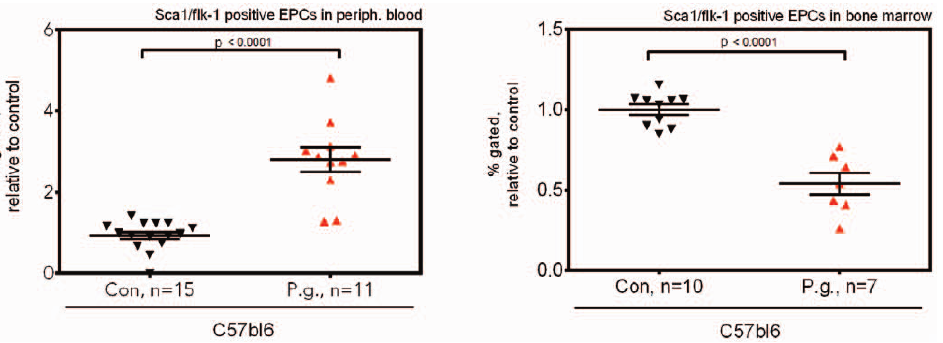
Figure 1. Bacteremia with P. gingivalis leads to mobilization of Sca1/flk1 progenitors from the bone marrow into peripheral blood of wildtype mice. Sca-1/flk1 progenitor cells (EPC) were quantified by flow cytometry in peripheral blood (left panel) or bone marrow (right panel) of C56bl6 wildtype mice after intravenous application of the periodontal pathogen P. gingivalis or saline (control). Data are presented as mean percentages of gated cells 6 SEM normalized to control, statistical testing was performed using unpaired